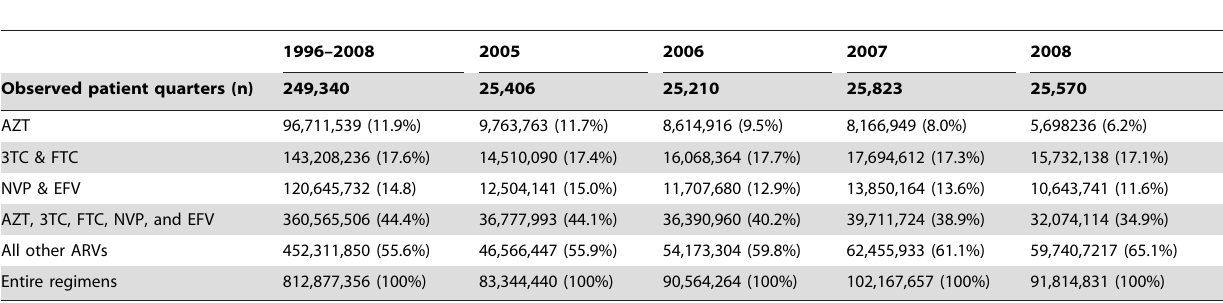
Table 5. Total costs of antiretroviral therapy by selected antiretroviral components potentially replaceable by generics in future (cumulative sum in J per period, and % of costs of the entire regimen).